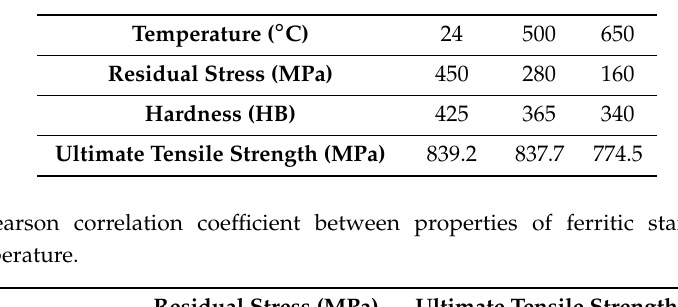
Table 24. Properties of ferritic stainless steel at di ff erent annealing temperatures [145].